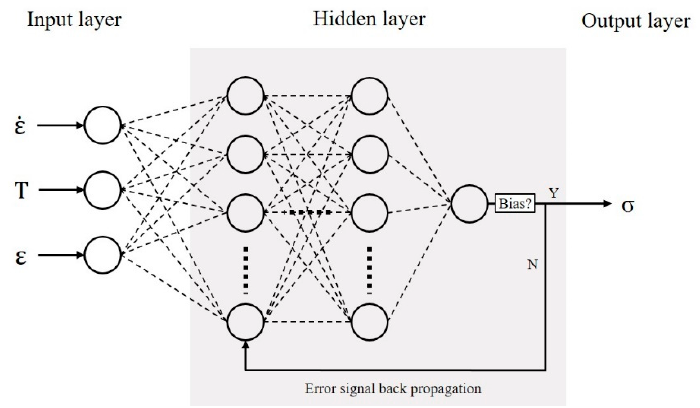
Figure 4. The schematic of ANN model.